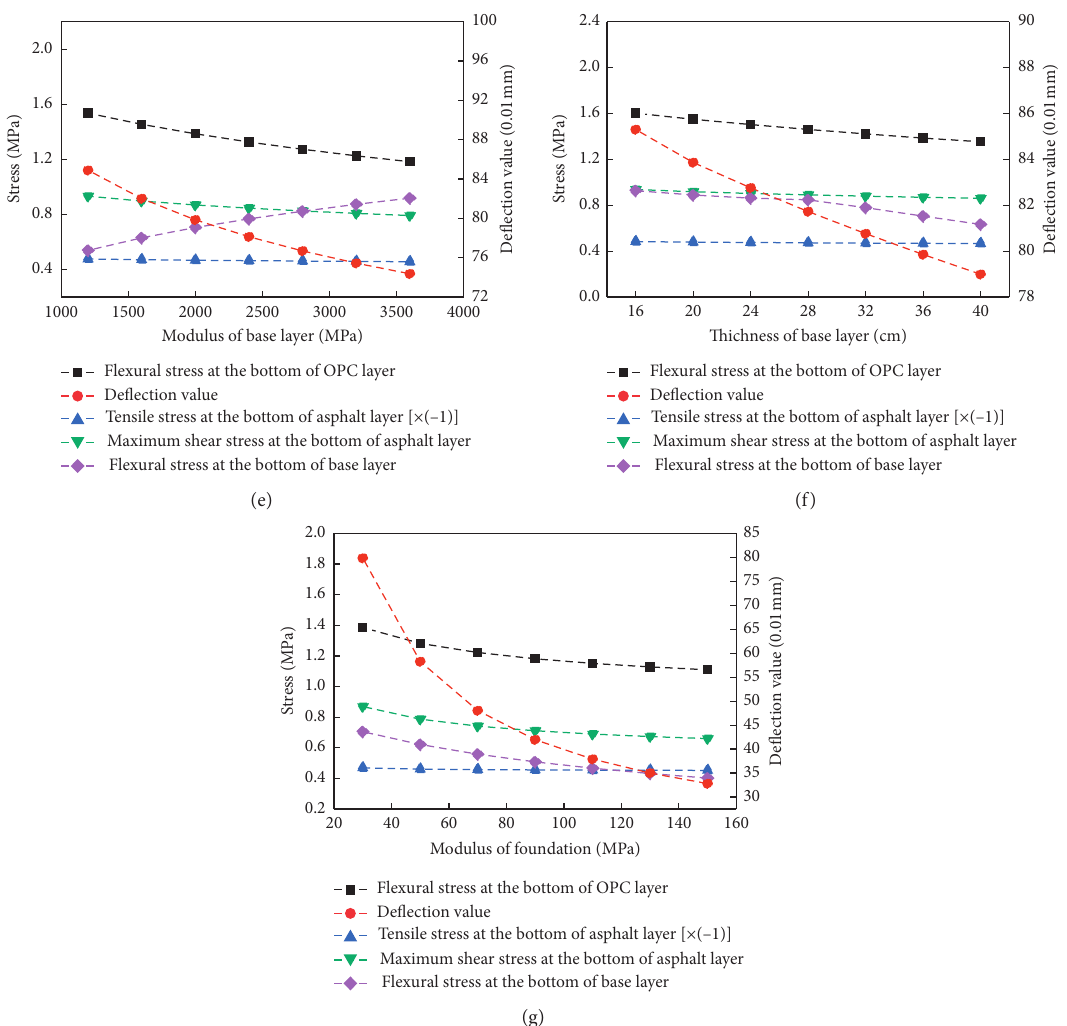
Figure 16: Influence of different layer parameters on stress and deflection. (a) Asphalt layer thickness. (b) Asphalt layer modulus. (c) OPC modulus. (d) OPC thickness. (e) Base layer modulus. (f) Base layer thickness. (g) Foundation